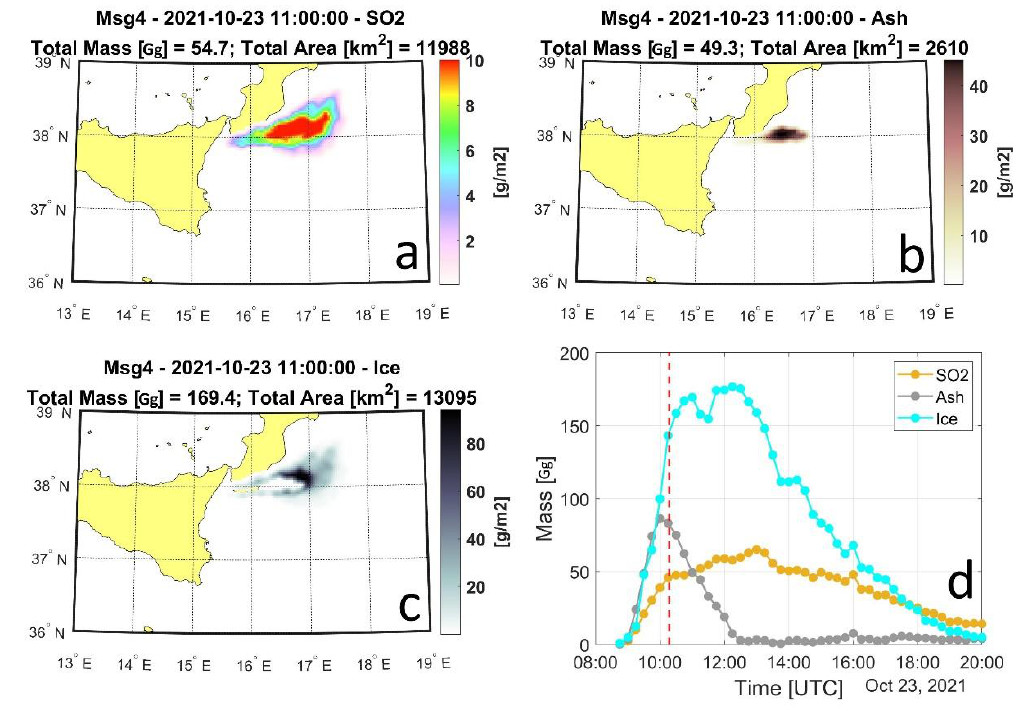
Figure 9. VPR outputs for 23 October 2021 Etna lava fountain: ( a ) SO 2 , ( b ) ash, and ( c ) ice columnar abundance [g/m 2 ] retrieval maps. ( d ) Ash/ice/SO 2 total mass [Gg] time series. The red dashed vertical line represents the end of the LF, obtained from Calvari and Nunnari [24].